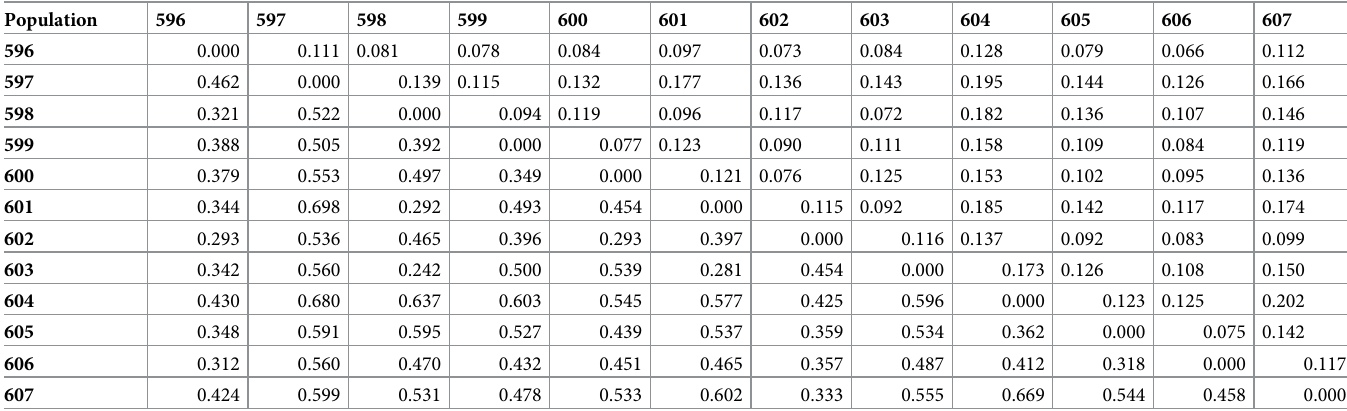
Table 4. Pairwise population matrix of Nei’s genetic distance (below diagonal) and F ST value (above diagonal) among the Nigerian-based populations.